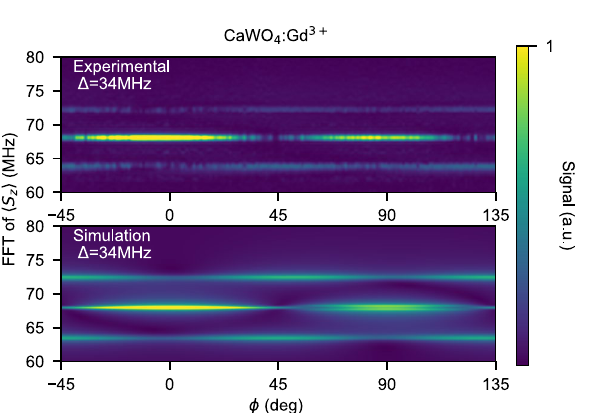
Figure 8. Phase-dependence of the Floquet mode. Experimental (top) and simulated (bottom) FFT of Rabi 34 MHz as a function of φ (amplitude is normalized to the highest peak). For h d / √ 3 oscillations for � = = 2 k π/ 4, k φ N , Rabi oscillations have a single mode F R while for φ = ∈ Floquet mode frequency is observed. While its frequency is fixed, the intensity of the Floquet mode changes gradually, with a period of π/ 2